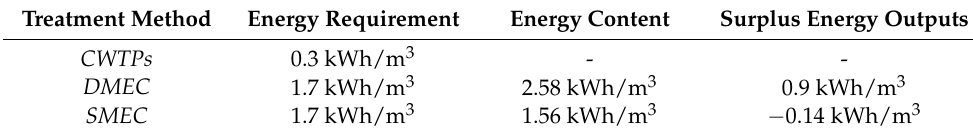
Table 2. The comparison of electricity consumption by MECs vs. CWTPs.